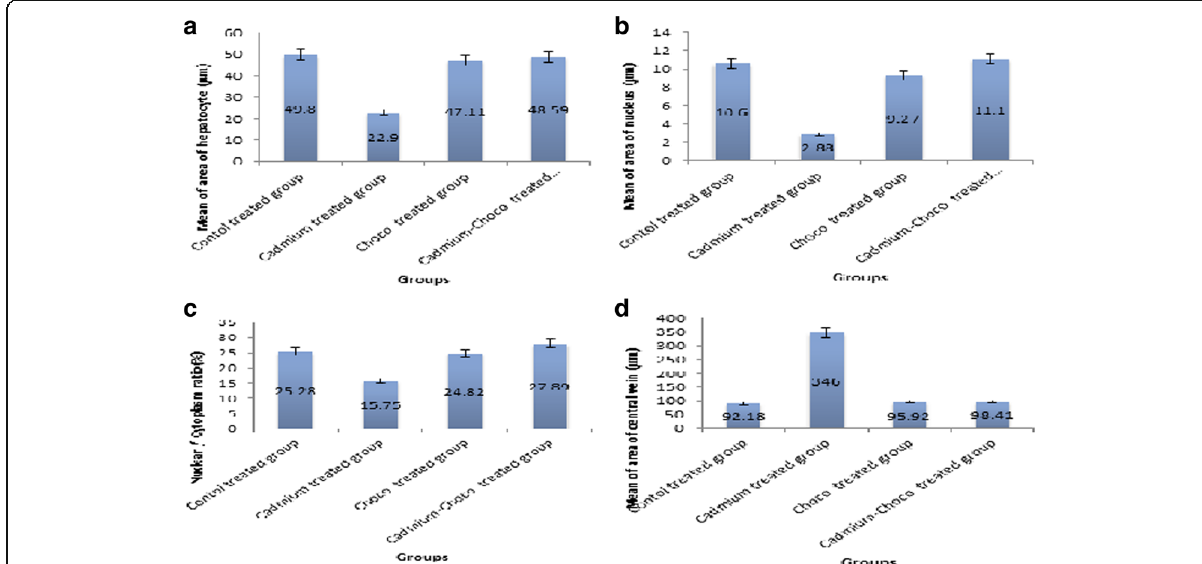
Fig. 3 Histomorphometrical analysis of hepatic tissues mice injected with nano-chocolate fortified with zinc and/or cadmium. a Area of hepatocyte ( μ m 2 ). b Area of nucleus ( μ m 2 ). c Nuclear/cytoplasm ratio. d Area of central vein ( μ m 2 )